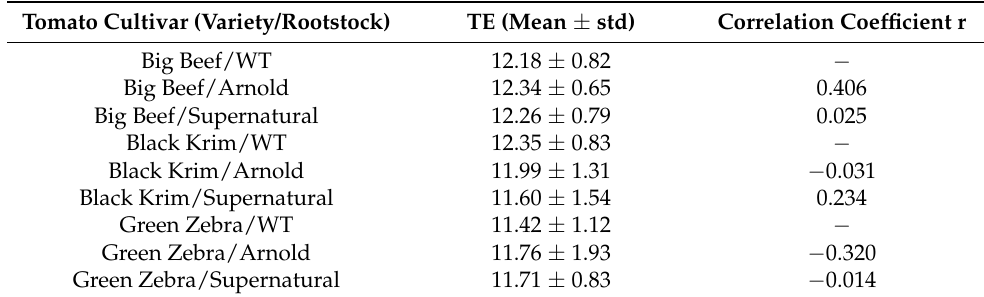
Table 3. Antioxidant capacity of tomato extracts as analyzed by the ABTS assay. Antioxidant capacity was calculated as trolox equivalents (TE; µ mol/g tomato dry weight). Analysis using Pearson correlation showed that the antioxidant capacity was not strongly correlated. A correlation coefficient of r < − 0.7 or r > 0.7 was considered a strong correlation.